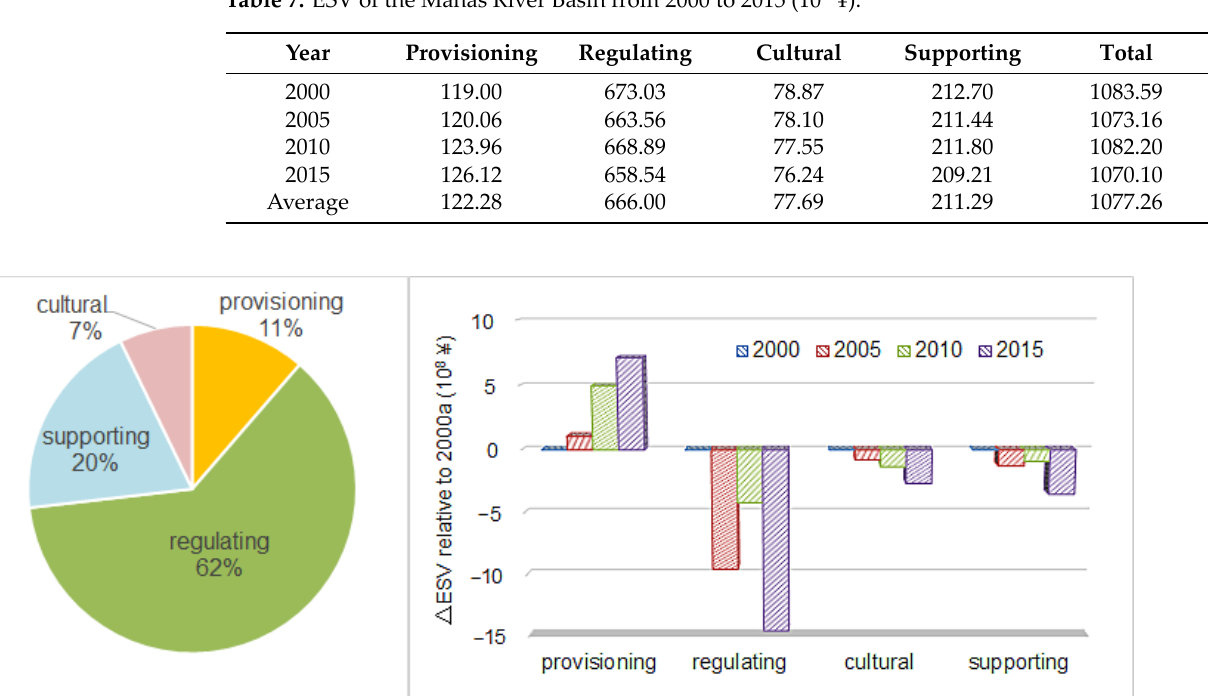
Table 8. HWV of different stakeholders in the basin from 2000 to 2015 (10 8 ¥).